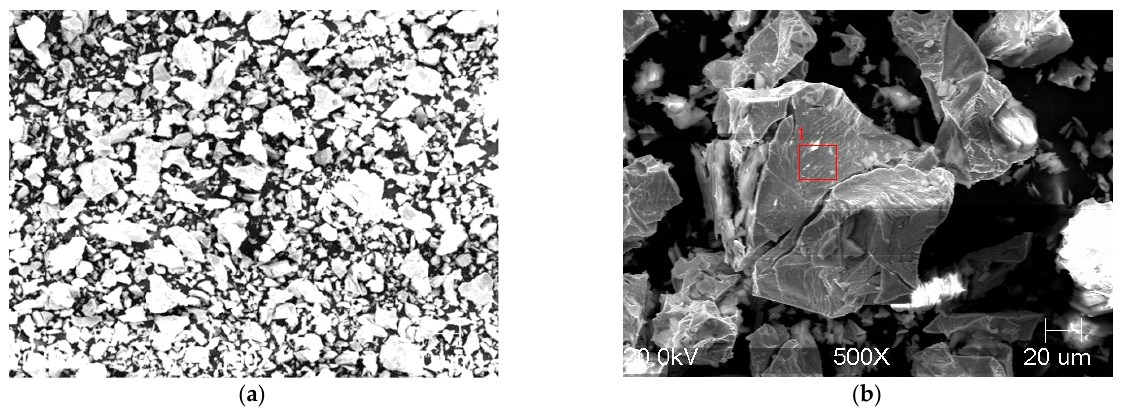
Figure 5. Microstructure of post-disintegration powder: different SEM microscope magnifications ( a , b ) and the site of EDS X-ray microanalysis ( b ).